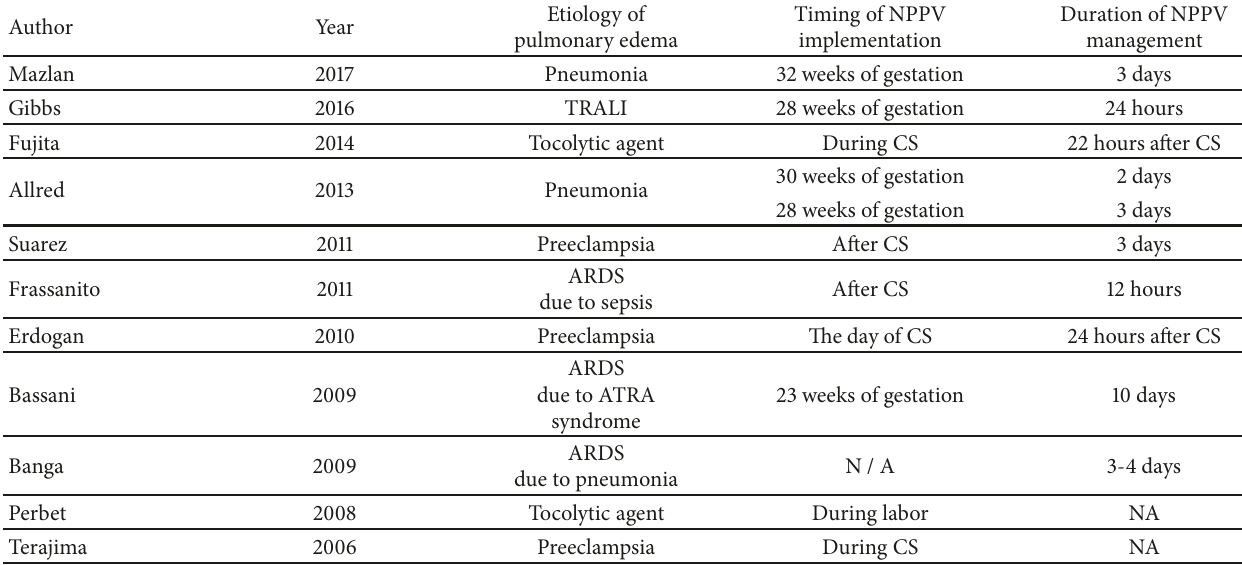
Table 2: NPPV management of pulmonary edema during pregnancy.